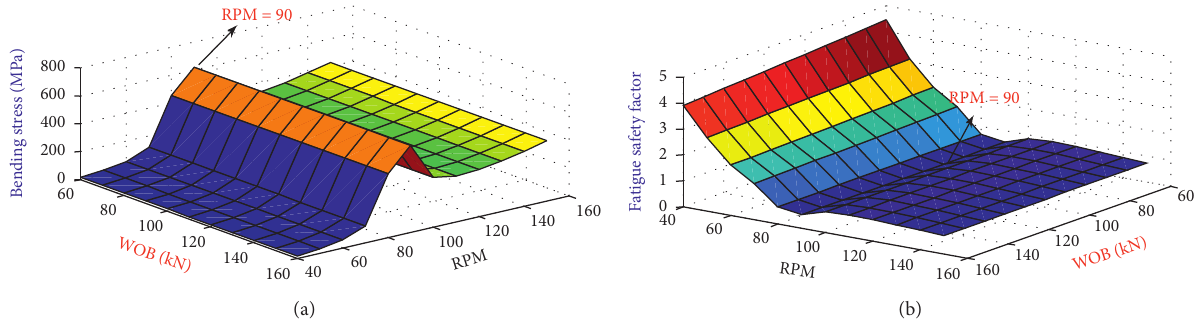
Figure 14: (a) Diagram of bending stress of point B . (b) Diagram of fatigue safety factor of point B